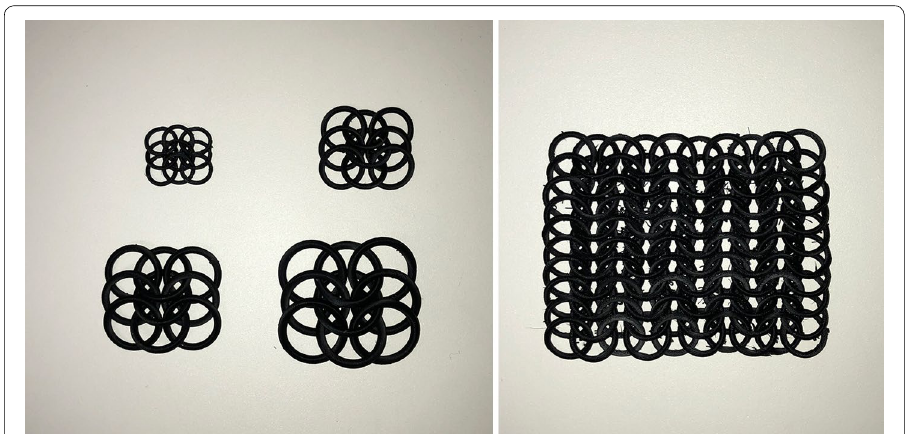
Fig. 18 a Developing a basic unit (left), b pattern printed in connected mode (right)